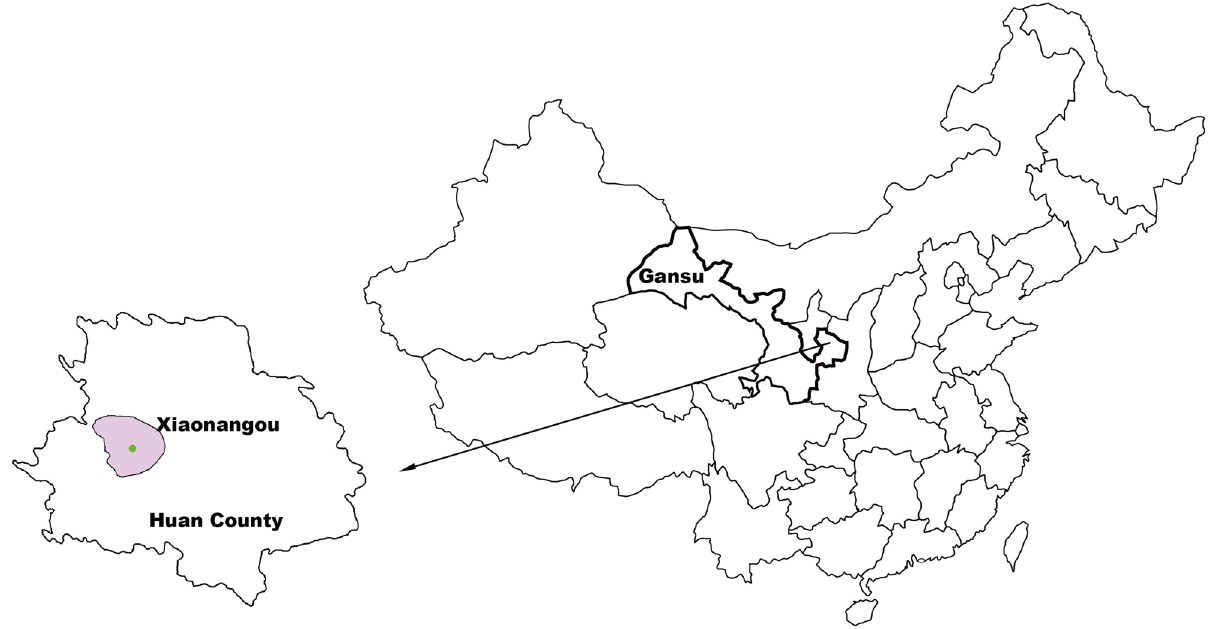
Figure 1. Map of the study location in Huan County, Gansu province of China. The green spot indicates the survey site Xiaonangou township. The map was generated in-house (the base map is available online http://d- maps. com) and was modified using Adobe software Illustrator